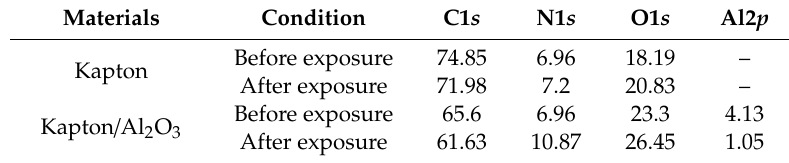
Figure 12. XPS full scan before and after atomic oxygen exposure: ( a , b ): Kapton, ( c , d ): Kapton/Al 2 O 3 . Table 1. Relative content of elements before and after atomic oxygen exposure (atomic percentage).